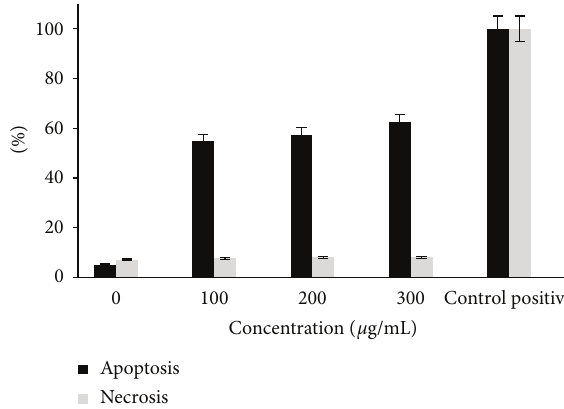
F 3: Effects of E . platyloba extract on cell viable of WEHI- 164 cells. Cells were incubated with the E . platyloba 100, 200, and 300 g/mL and control positive (especial for cell death detection ELISA kit) at 24h. e induced apoptosis (internucleosomal DNA fragmentation) was then assessed by cell death detection ELISA. 𝜇𝜇 Data presented are the mean SEM of three independent experi- ±